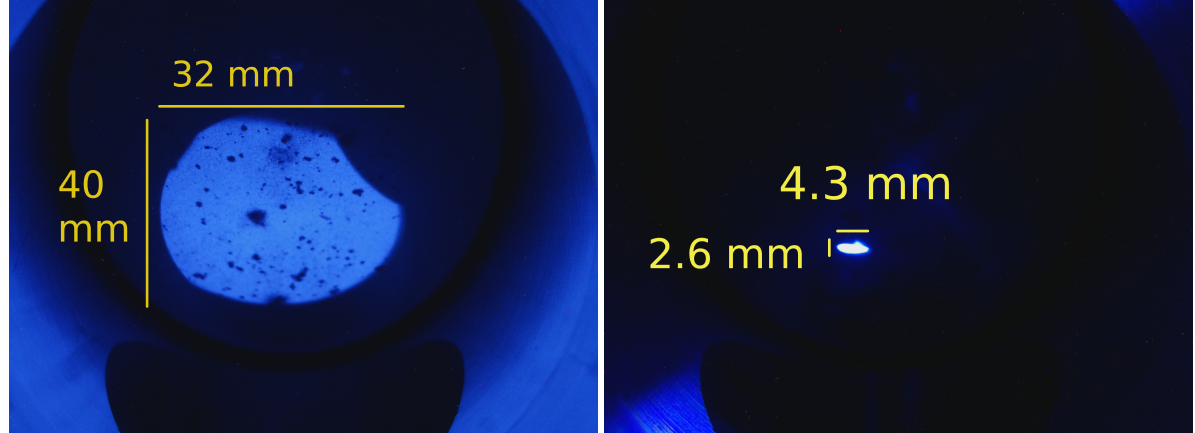
Figure 7. The two-dimensional profile of the beam measured with the π 2 detector before ( left ) and after ( right ) the optimisation procedure performed by the AFS. The real dimension of the beam is reported, once the effect of the vertical tilt of the scintillating foil is corrected for. The dark spots in the left figure are due to inhomogeneities in the coating of the scintillating foil.